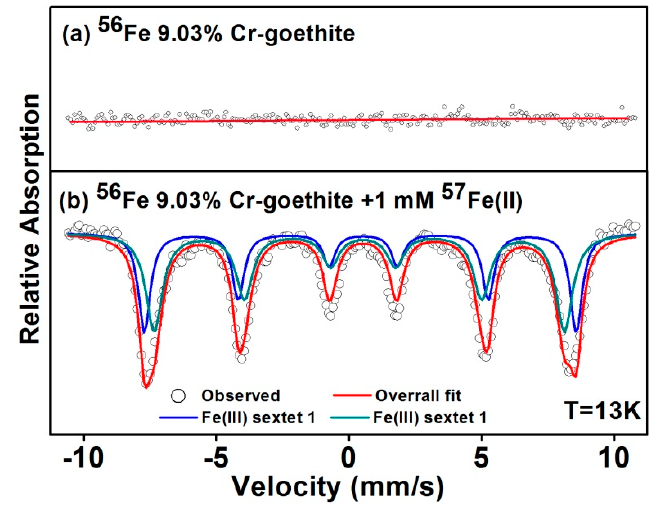
Figure 6. Mössbauer spectra of ( a ) unreacted 9.03% Cr- 56 goethite, and ( b ) 9.03% Cr- 56 goethite following reaction with 1.0 mM 57 Fe(II) aq for 30 days.